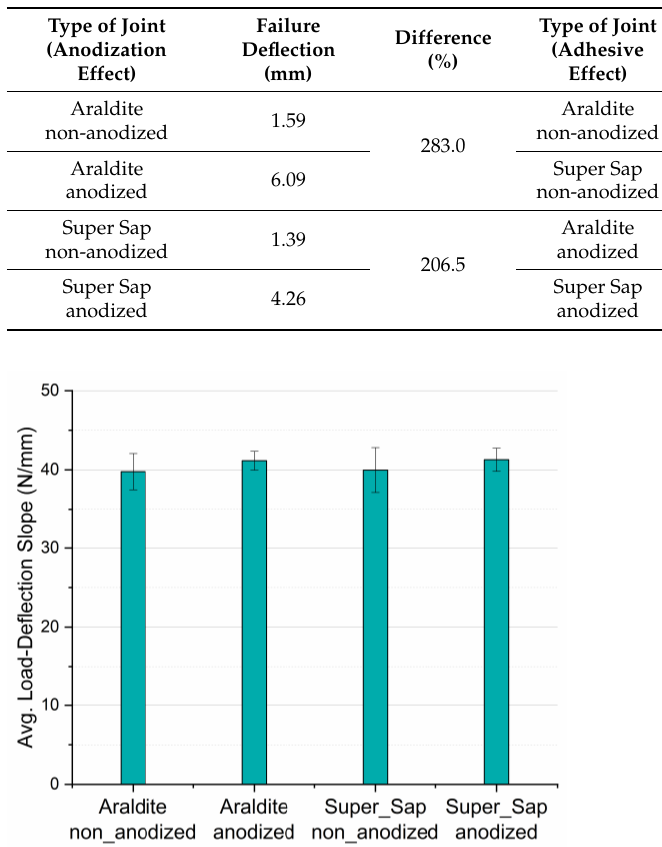
Table 5. Comparison of three-point bending average failure deflection values for the different types of aluminum single-lap joints.